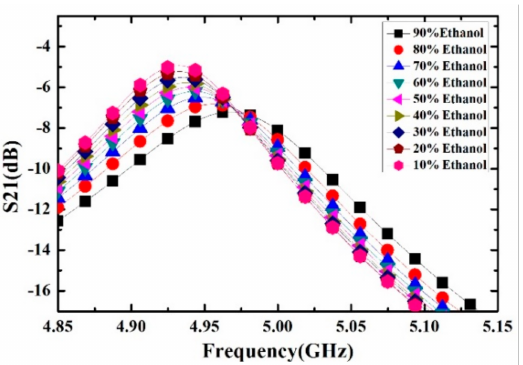
Figure 10. Measured transmission response of different concentrations of ethanol solution.